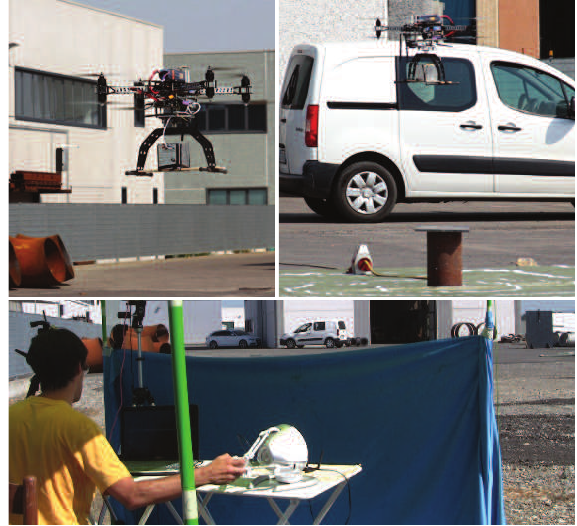
Figure 1. UAV equipped with a CdZnTe gamma-ray detector in flying tests (top). The operator using the visuo-haptic user interface (bottom). The operator sits in front of a cloth that prevents him from seeing the nuclear source on the